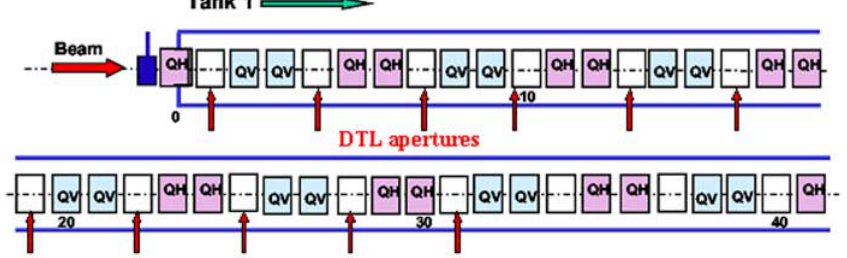
FIG. 15. (Color) Schematic diagram of DTL tank 1 showing the location of proposed collimators.